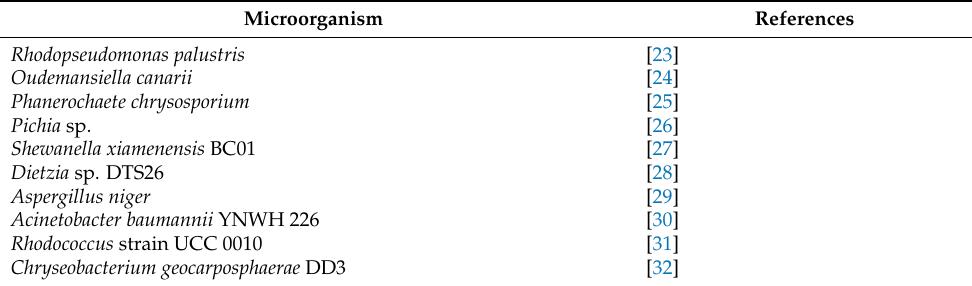
Table 1. List of microorganisms efficiently able to degrade Congo red